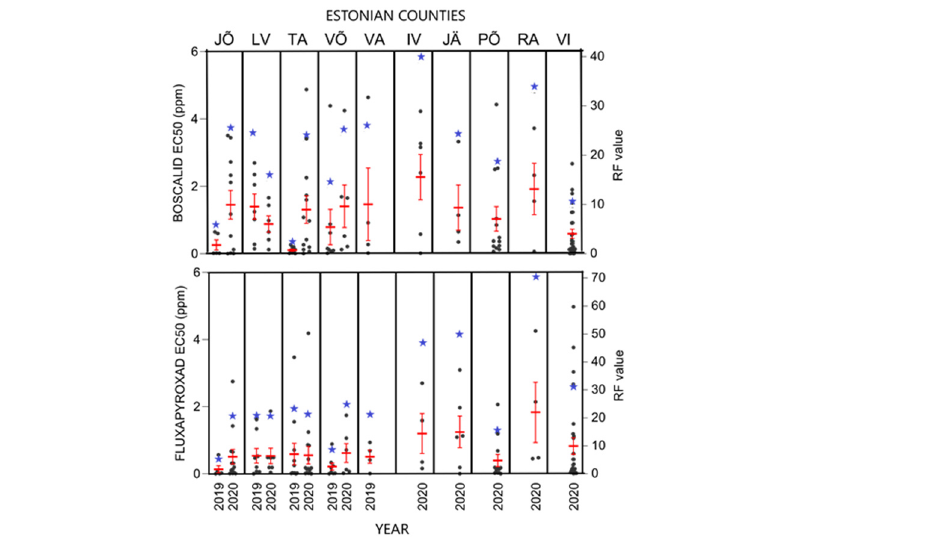
Figure 5. SDHI fungicide sensitivity in R. collo-cygni population in Estonia by counties and collection years. Black dots show individual EC 50 values (ppm), red error bars represent standard error of the mean EC 50 value, and blue stars are average resistance factor (RF) values. Counties presented